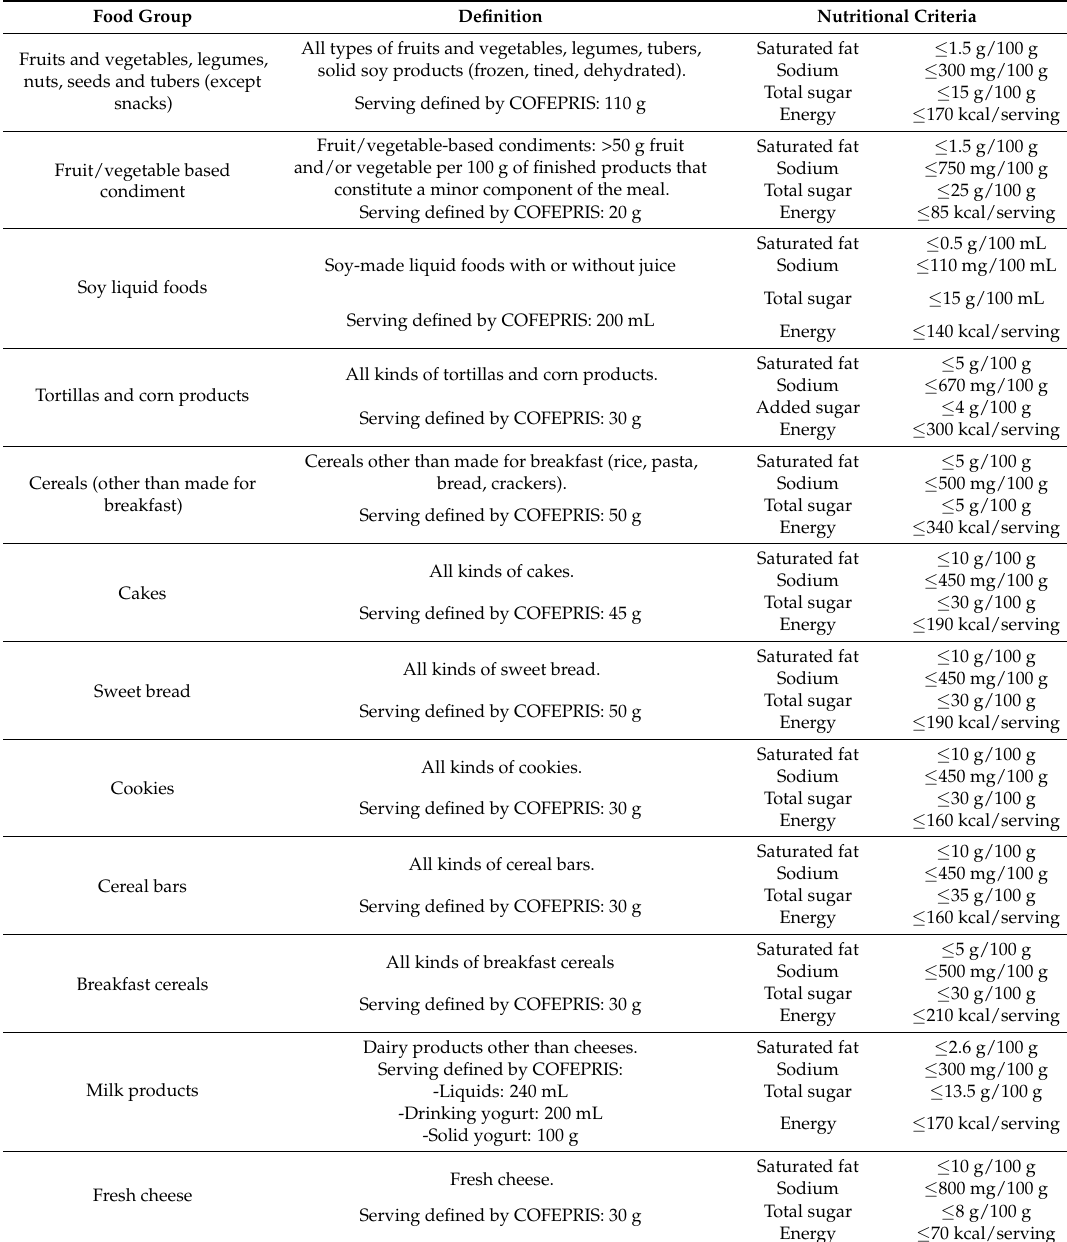
Table A2. FOP nutritional labeling criteria of the Commission for the Protection against Sanitary